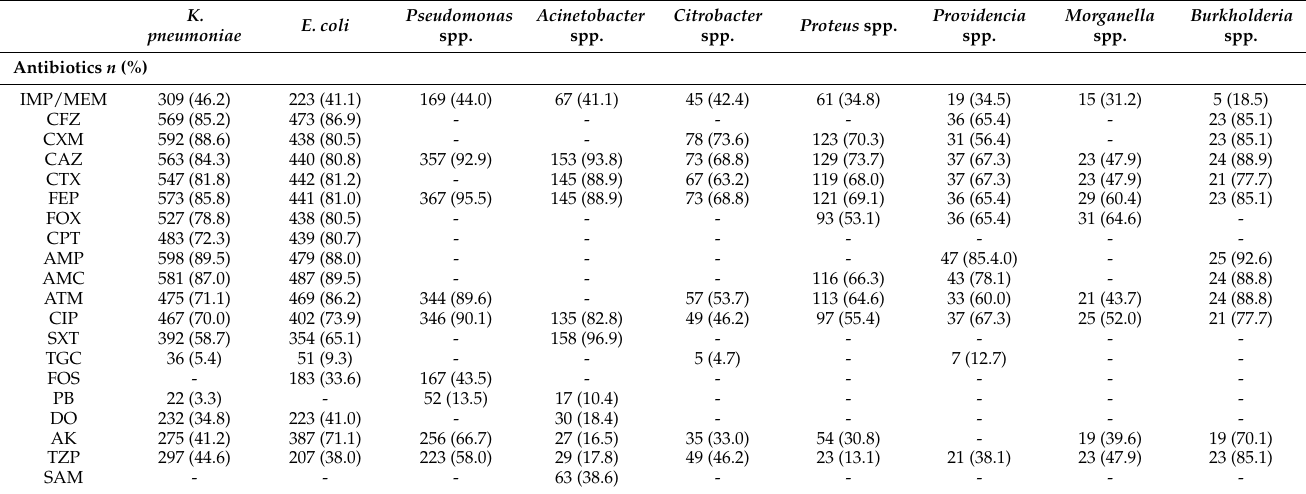
Table 2. Antimicrobial resistance profile of detected